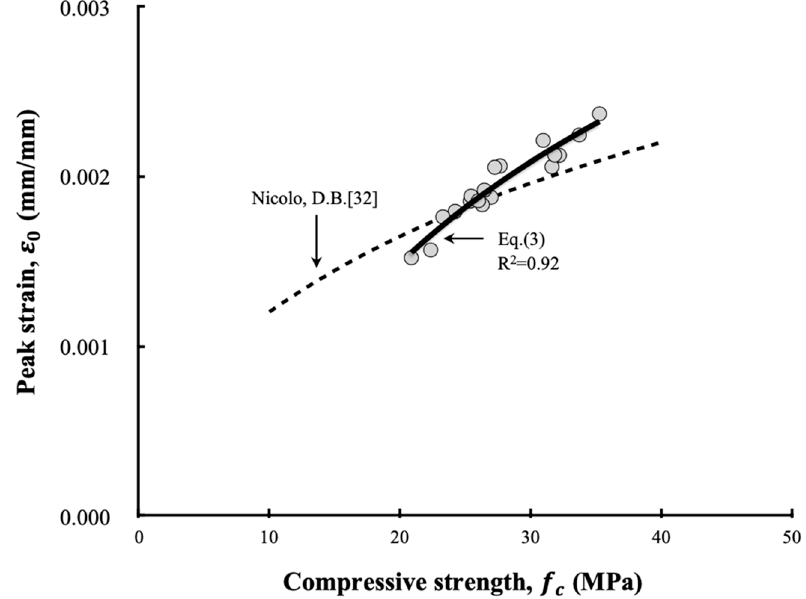
Figure 19. Peak strain of LRM concrete with cement type.